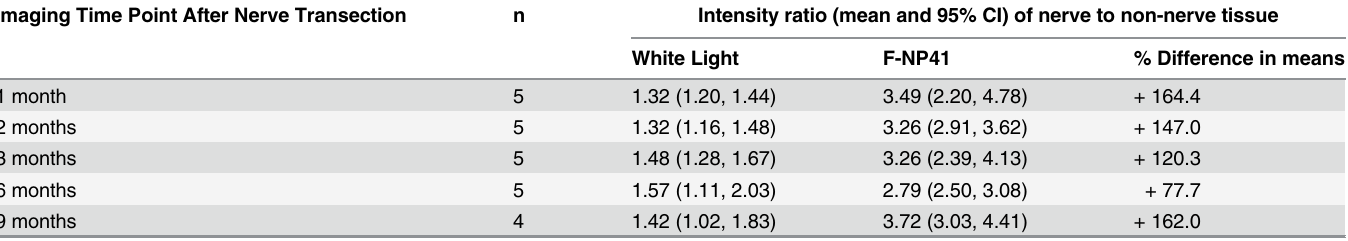
Fluorescent labeling signi fi cantly increases nerve to background contrast up to 9 months after main branch transection. P-values comparing F-NP41 and WL were all < 0.01 after Bonferroni